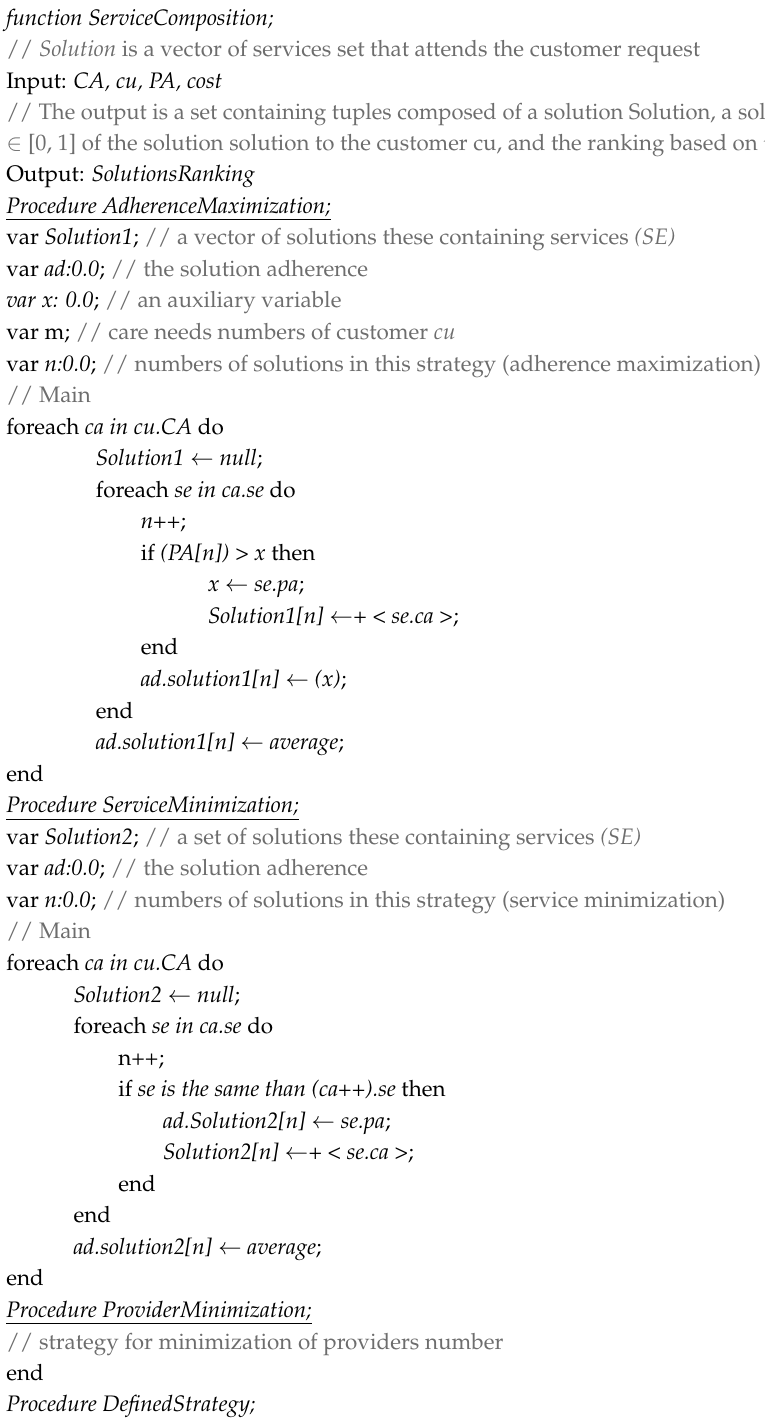
Algorithm 4 Service Composition and Ranking